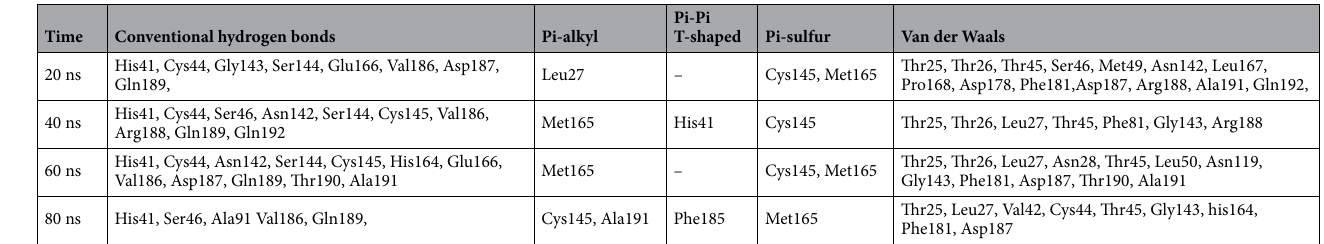
Table 1. The interacting residues between Theaflavin 3-gallate and M pro at different time intervals during the